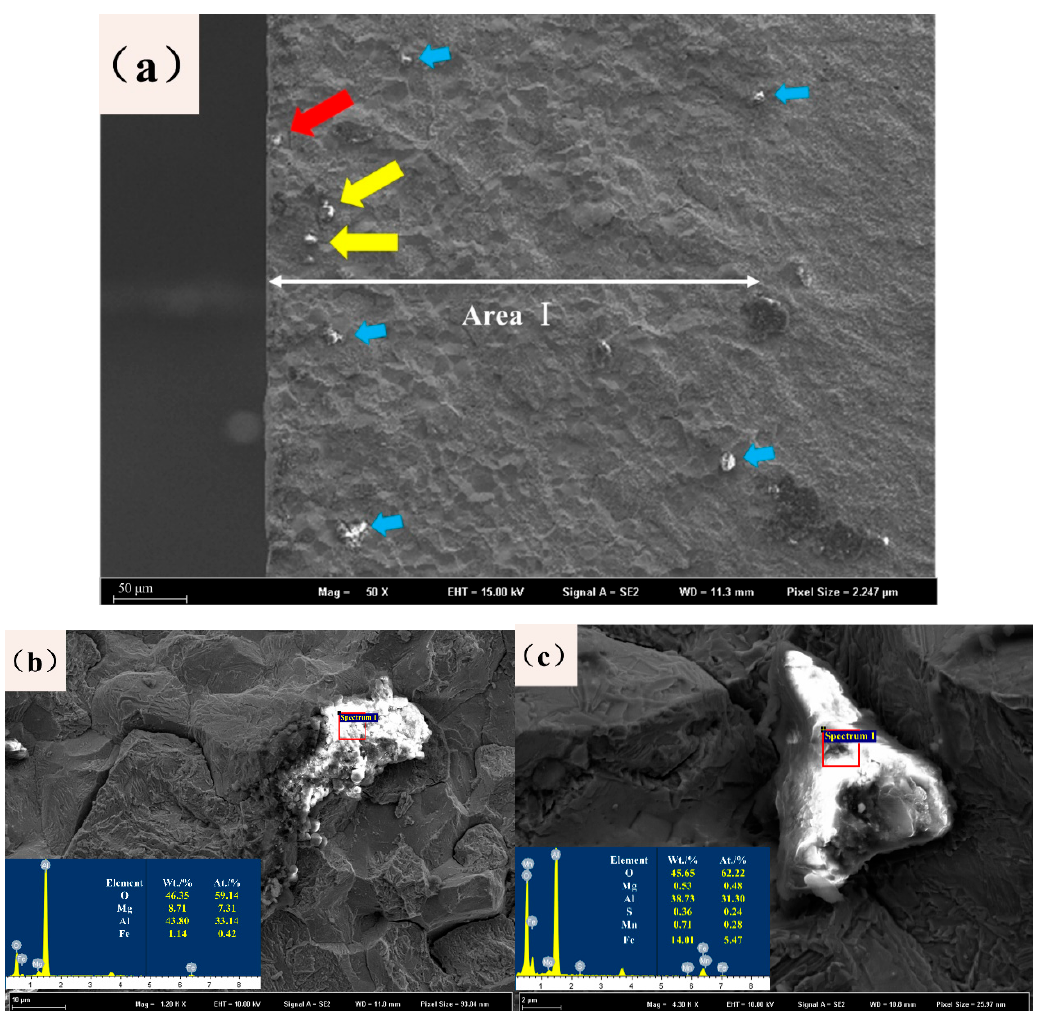
Figure 14. Fatigue fracture morphology of the sample after three-point bending fractures: ( a ) appearance of area I, ( b ) cracks in the inclusions, and ( c ) crack passing through the inclusions.